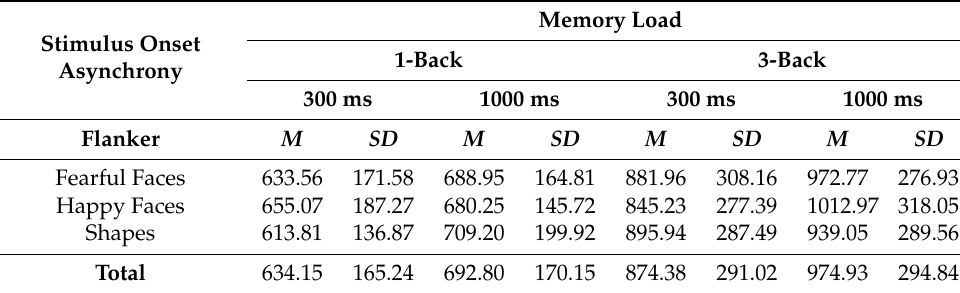
Table 14. Means and SDs of participants’ reaction times for hit trials for Study